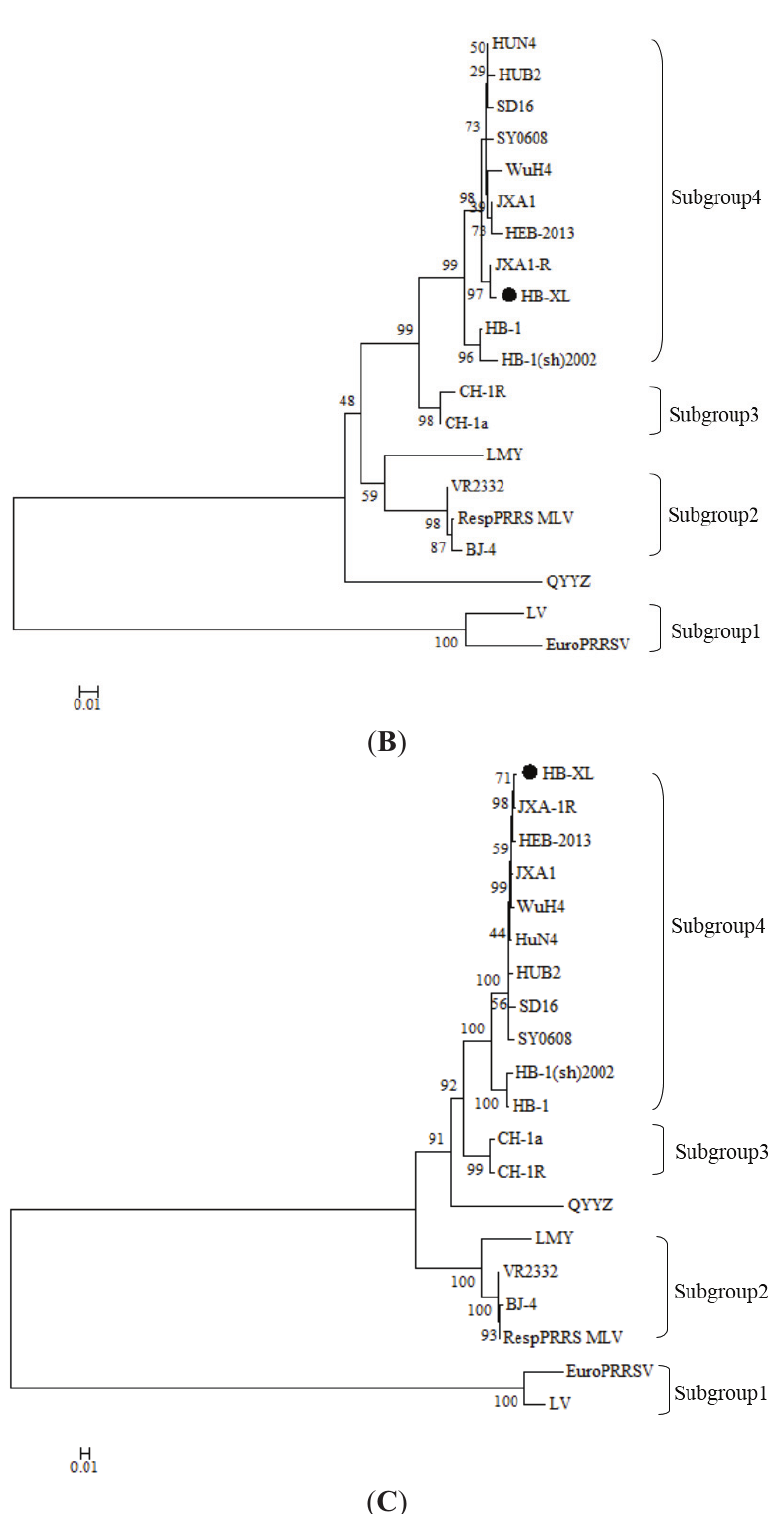
Figure 2. Phylogenetic trees based on the complete genome, ORF5, and Nsp2 of PRRSV. ( A ) Complete genome; ( B ) Open reading frame (ORF); ( C ) Nsp2 nucleotide. The multiple sequence alignment was obtained using the MEGA5 program, and the phylogenetic tree was constructed by the neighbor-joining method using 1000 bootstrap replicates of the sequence data. Bootstrap confidence limits are shown at each node. The isolate identified in this study is indicated by black